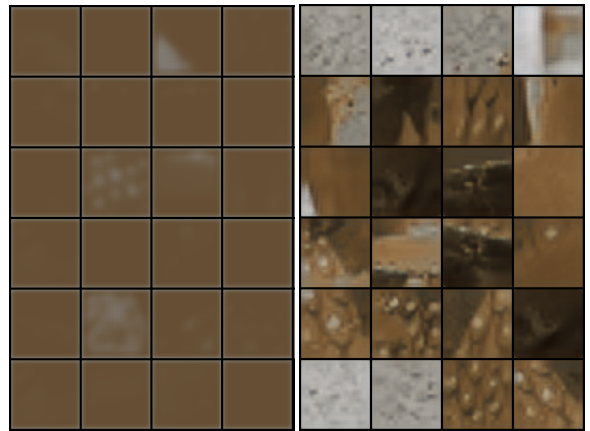
Figure 6. Examples of CAE reconstruction for the first (left) and the last (right)